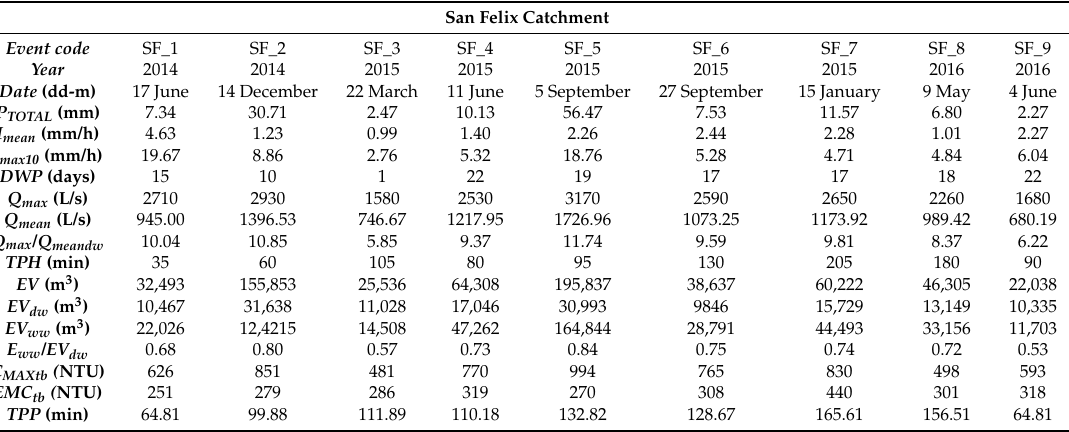
Table 5. Variables of rainfall events at San Felix